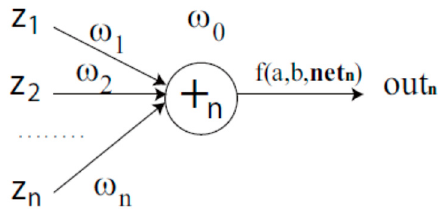
Figure 16. A complex-valued flexible neuron operator.